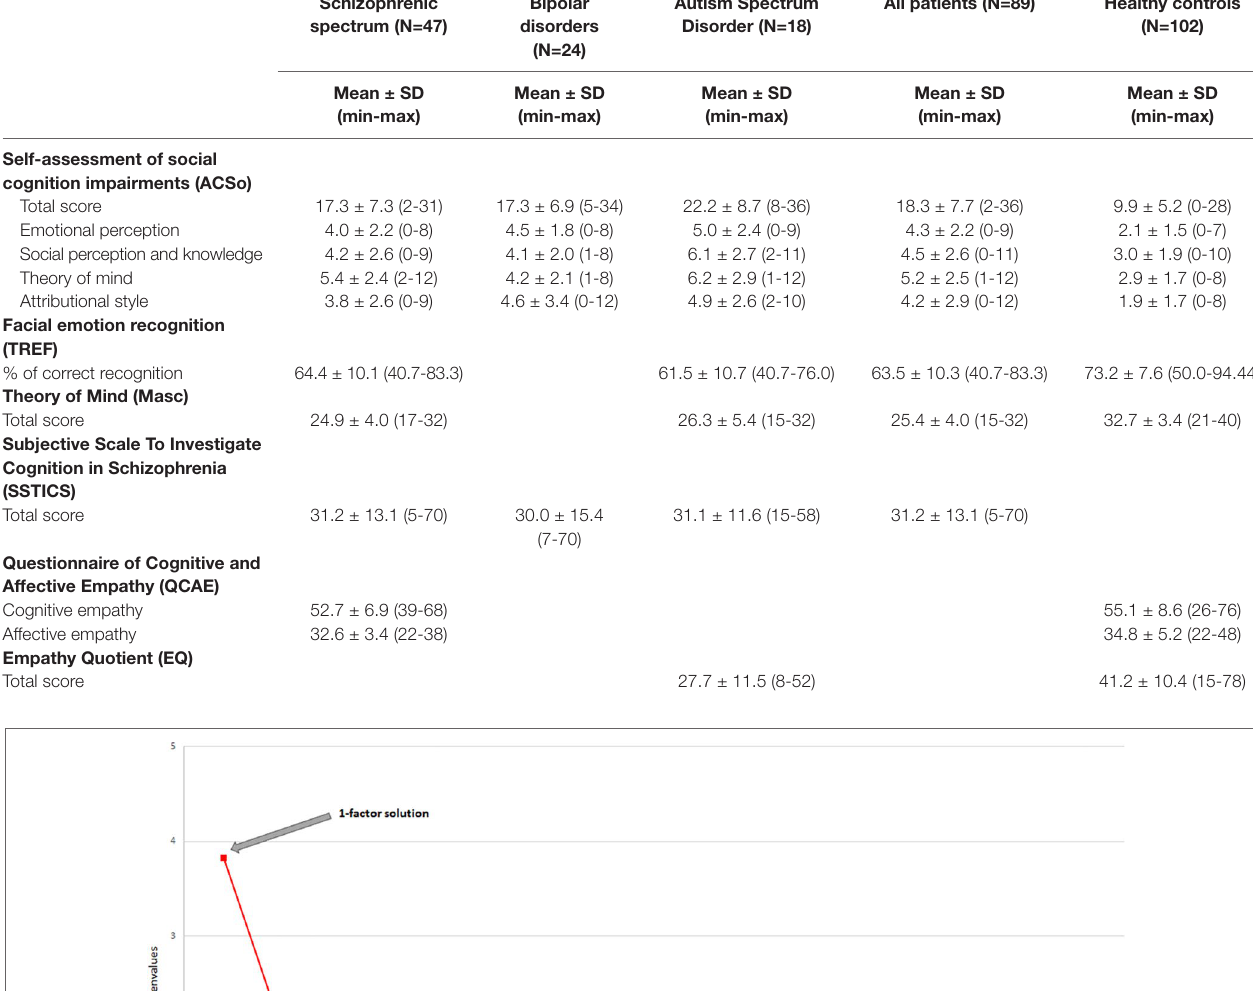
TABle 2 | Scores from the ACSo, the TREF, the MASC, the SSTICS, the QCAE and the EQ in all participants (mean ± standard deviation; min-max).